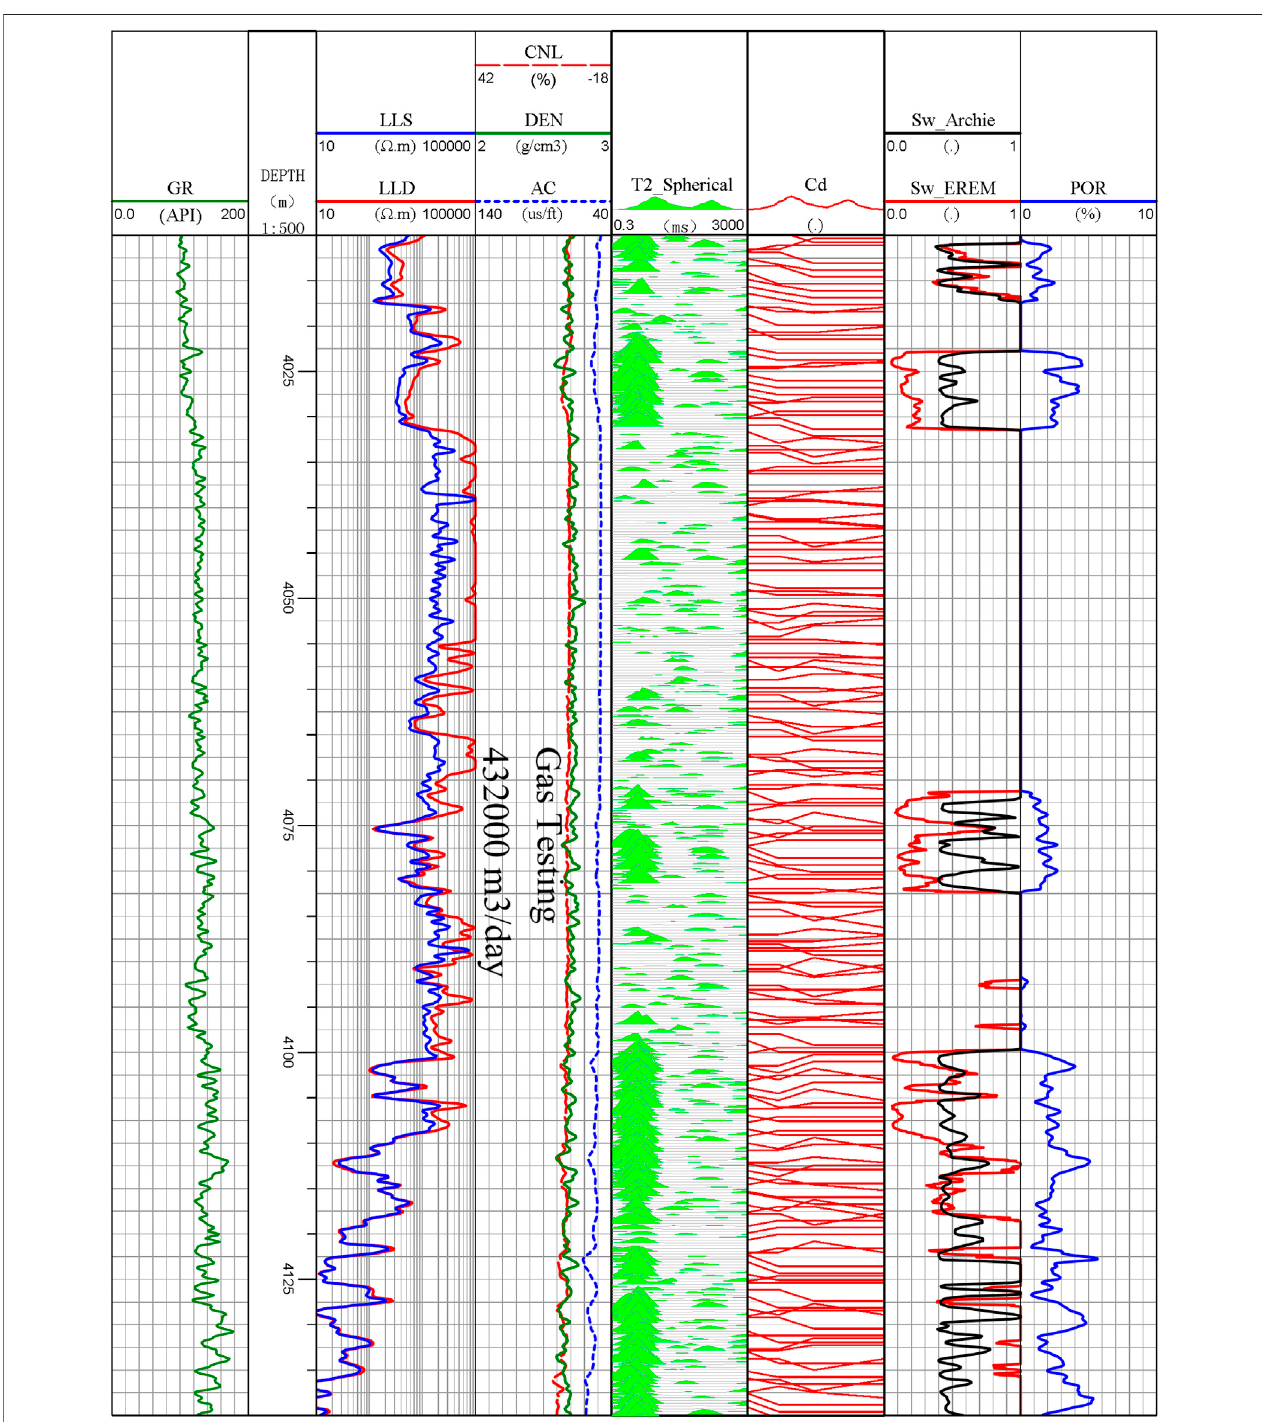
FIGURE 8 | Comparison of saturation estimation between the improved EREM model and Archie model in Well XX3.